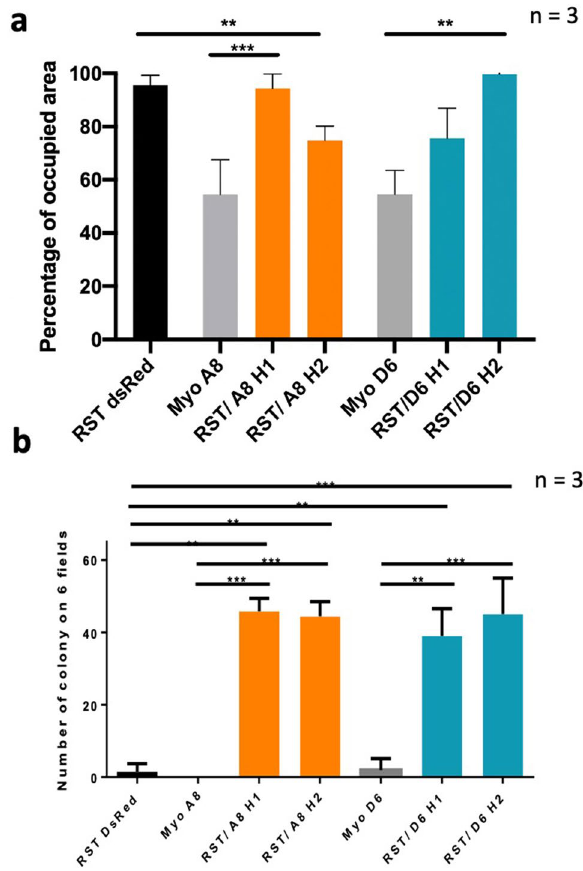
Figure 3. Hybrids are more aggressive than parental cell lines. ( a ) Evaluation of hybrid migration. Experiments performed in triplicate (n = 3). ( b ) Number of colonies obtained by soft agar assay. Data represent average number of colonies scored in a total of six fields (two fields per well, three wells per experiment, n = 3). Statistical analyses were done using Krustall Wallis’s test following Dunns’s multiple comparison test and Bonferroni’s adjustment (** P < 0.001, *** P <